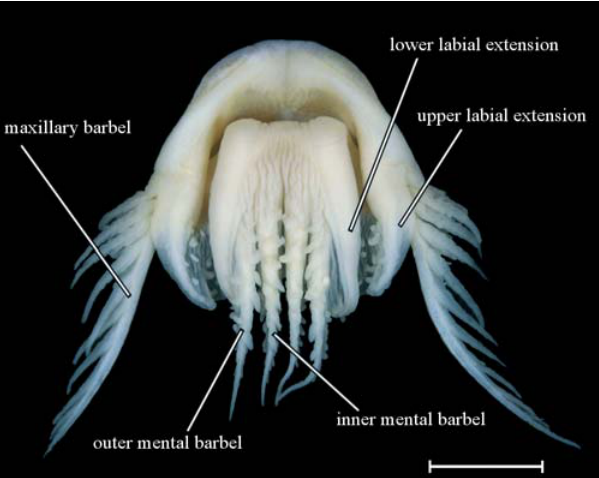
Fig. 3. Mouth, barbels and lips of Leptodoras oyakawai , MZUSP 97909, holotype, 120.5 mm SL, in ventral view. Scale bar 5